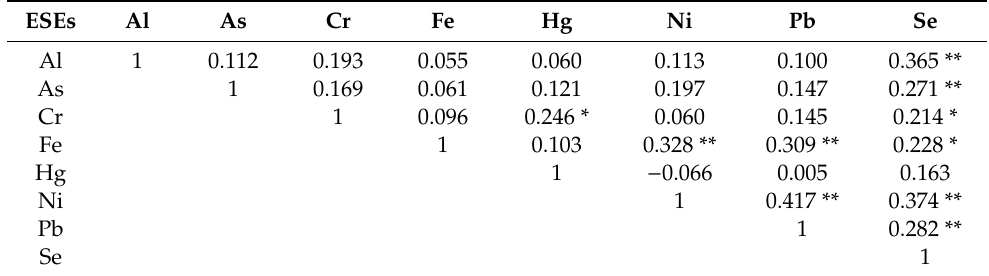
Table 3. Pearson’s correlation matrix during postmonsoon